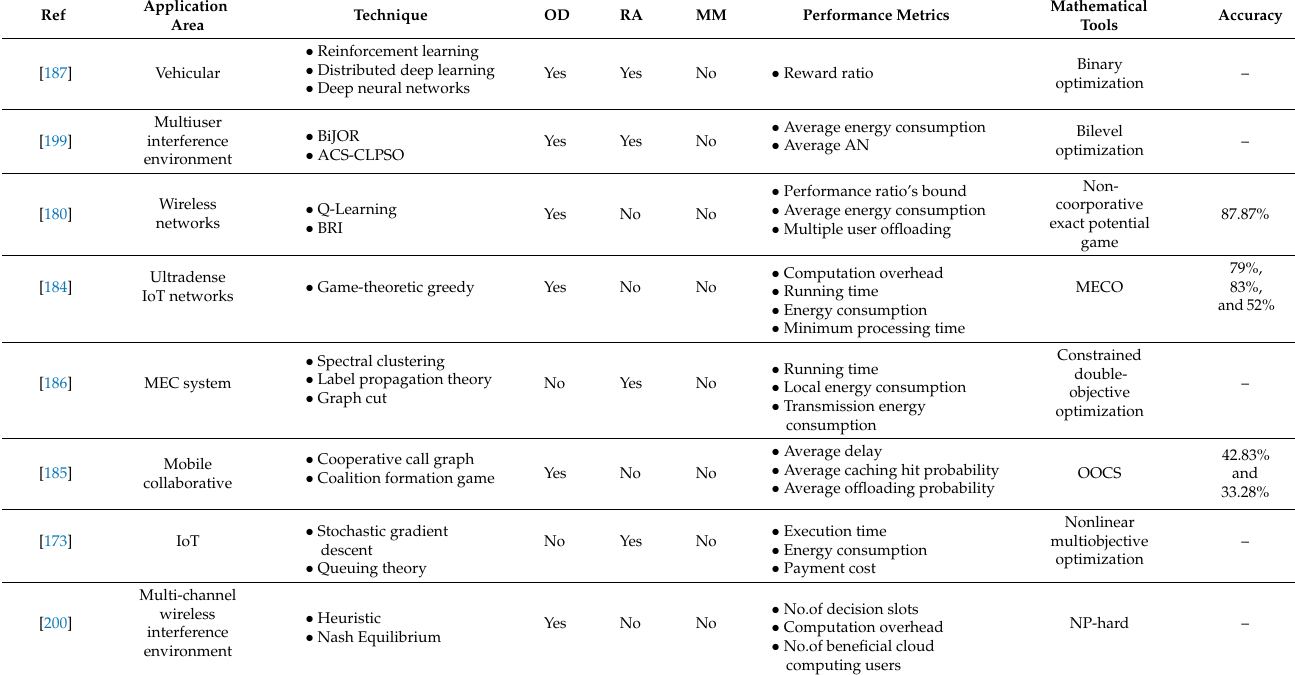
Table 6. Application areas, techniques and other metrics associated with computation offloading (OD—offloading decision, RA—resource allocation, MM—mobility